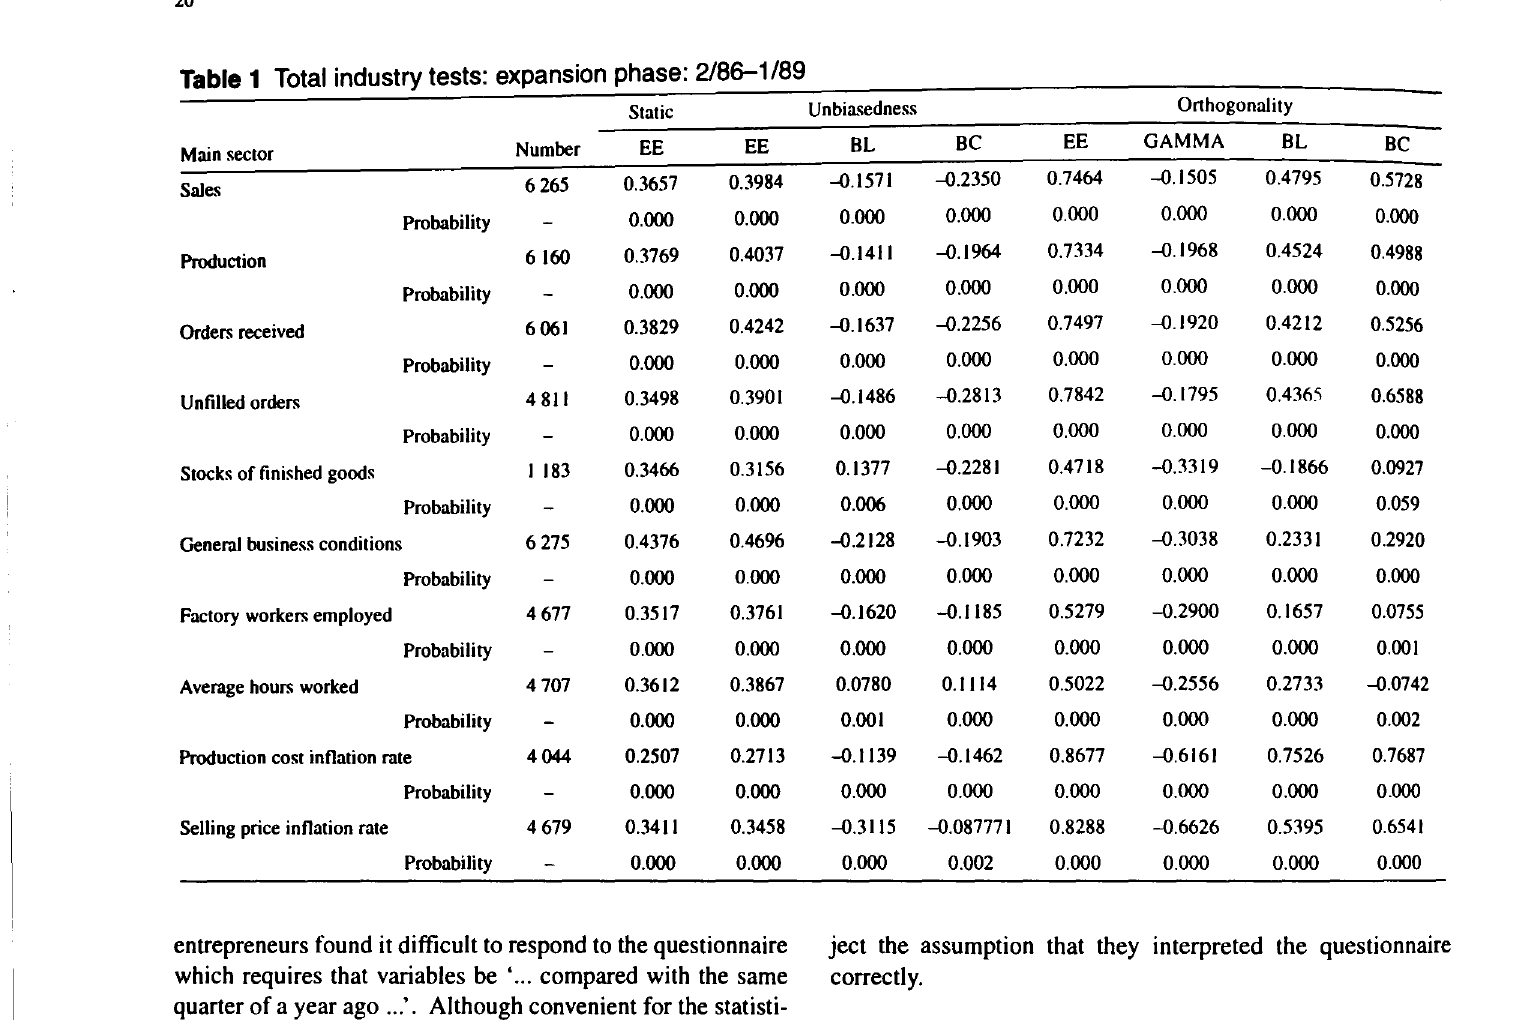
Table 1 Total industry tests: expansion phase: